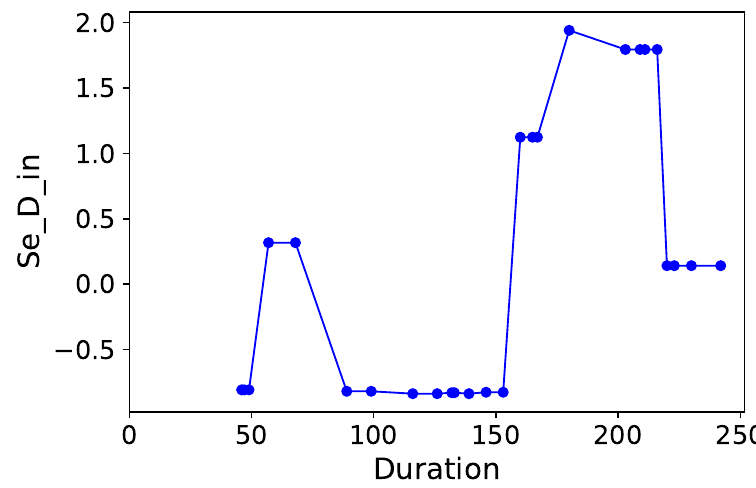
Figure A11. Normalized selenium inlet flowrate for Reactor